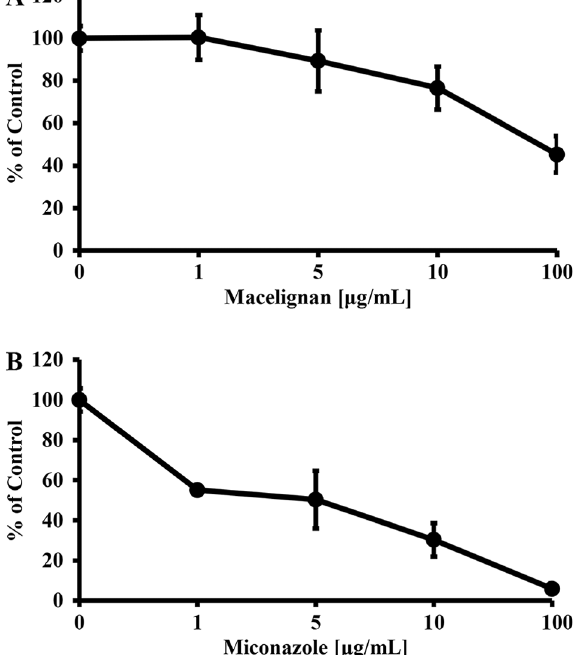
Figure 1. Cytotoxic effects of the macelignan ( A ) and miconazole ( B ) against hepG2 cells. HepG2 cells were treated with the indicated concentrations of macelignan and miconazole for 24 h. Data are reported as means ± SD of three independent experiments.